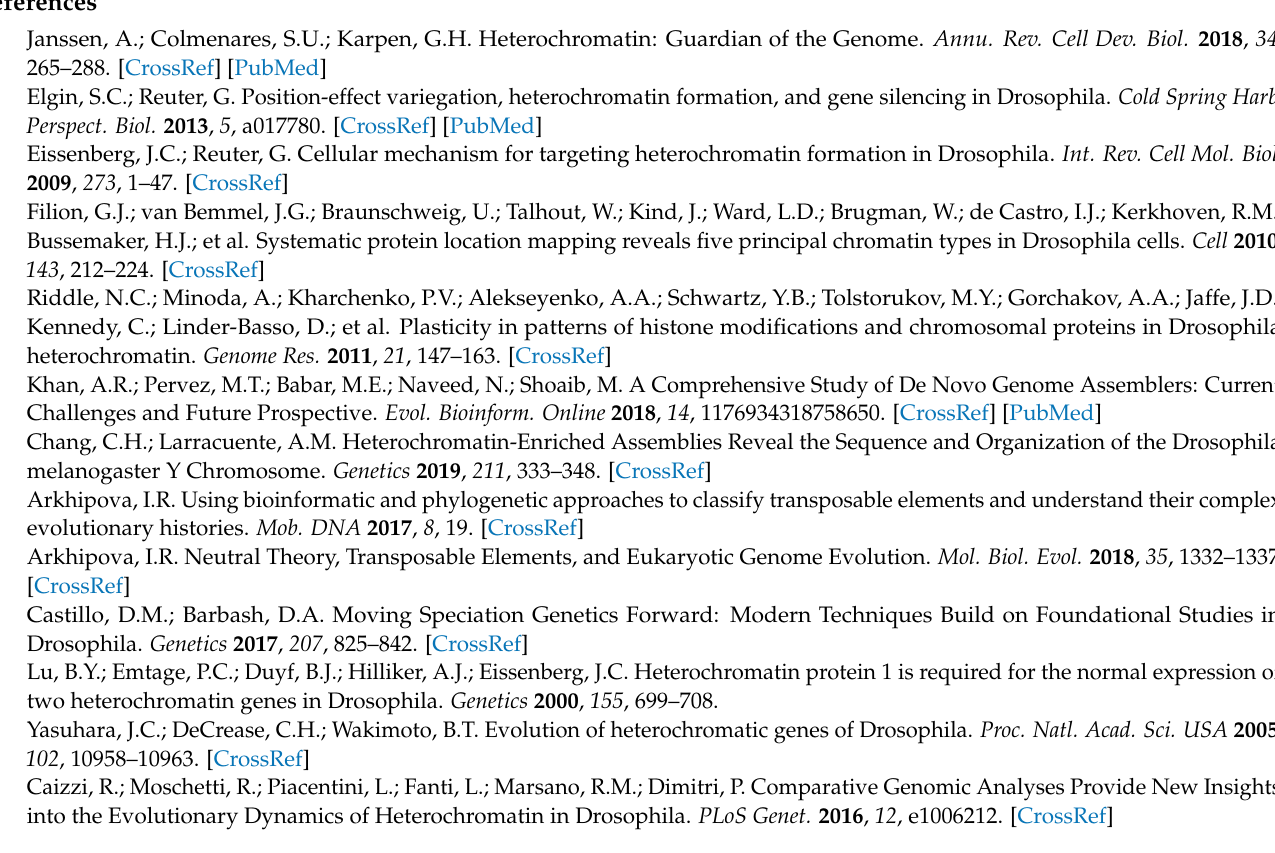
are not given for most of the genes due to the absence of their annotations and homology to closely related species; Figure S4: The number of unique piRNAs quantified for each TE subclass derived from a genomic region. Levels of piRNA expression were normalized to the sequencing depth (RPM); Figure S5: Landscape of unique piRNAs mapping on five studied heterochromatic genes of D. virilis . Mapping data of piRNAs are not normalized. RNA-seq reads were normalized to the sequencing depth (RPM, reads per million). Repeats and genes are shown in different tracks; Table S1: Accession numbers and genomic coordinates of the studied genes in Drosophila